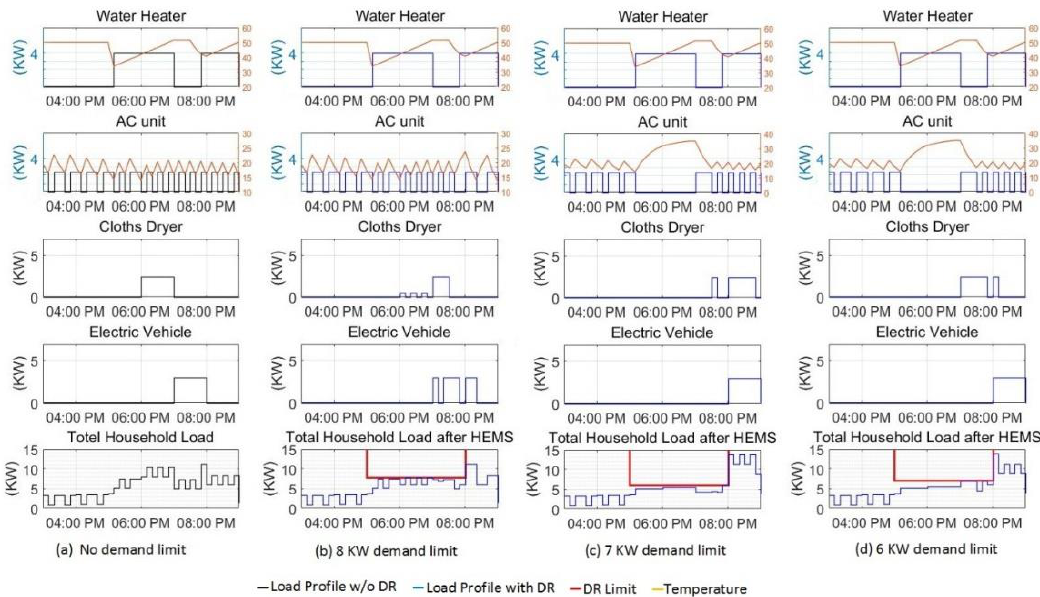
Figure 6. Home load profile for HEMS based on load power curtailment.